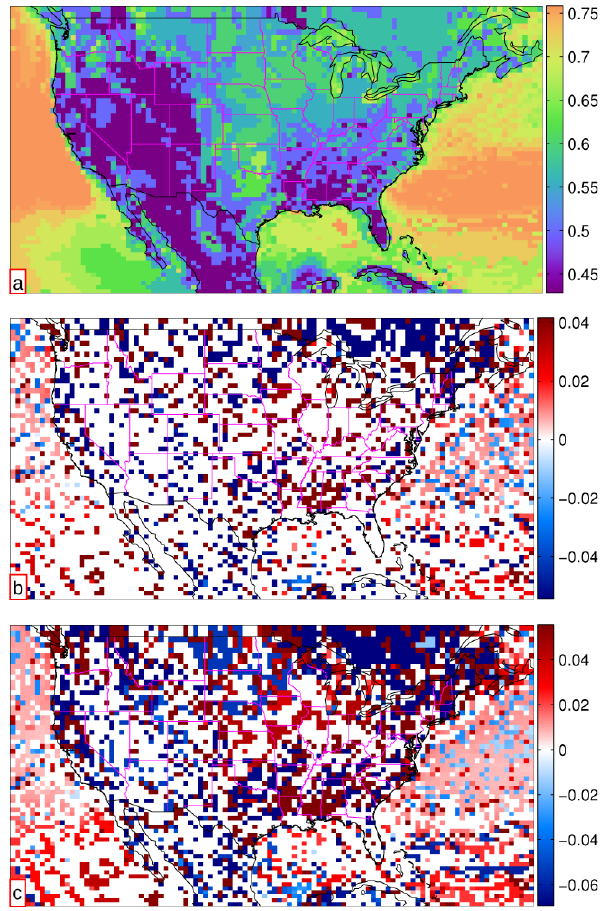
Fig. 16. Variation of the coefficient of variation of WPD episode lengths at different heights. (a) shows the RCoV of episode lengths at 80m and (b) and (c) show the difference RCoV of episode lengths at 100m and 120m from that at